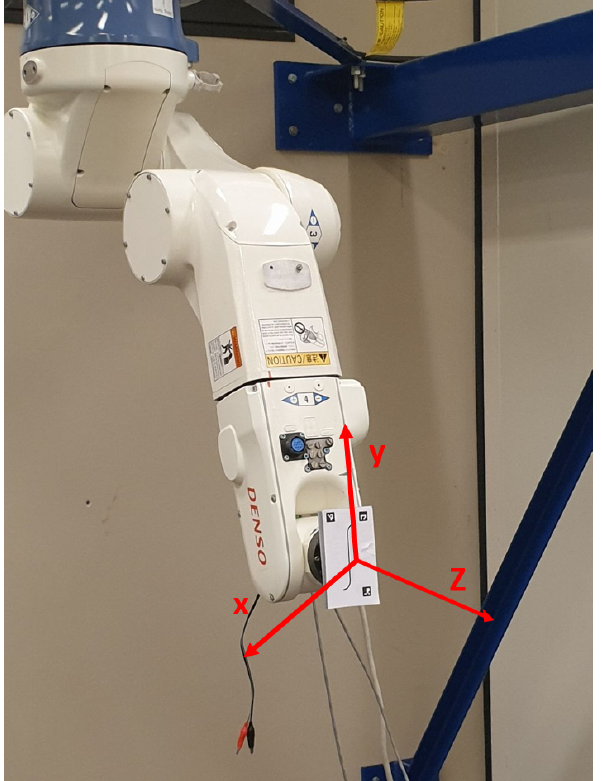
Figure 15. An anthropomorphic robot is used in order to define the working range of the developed device in a controlled